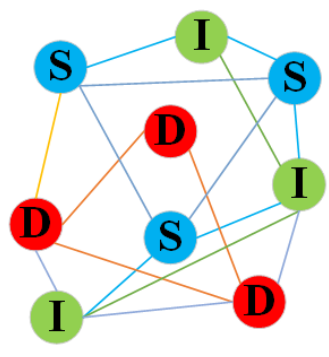
Figure 1. Schematic diagram of a heterogeneous combat network. Node S denotes the sensor entity, node D denotes the decision entity, and node I denotes the influence